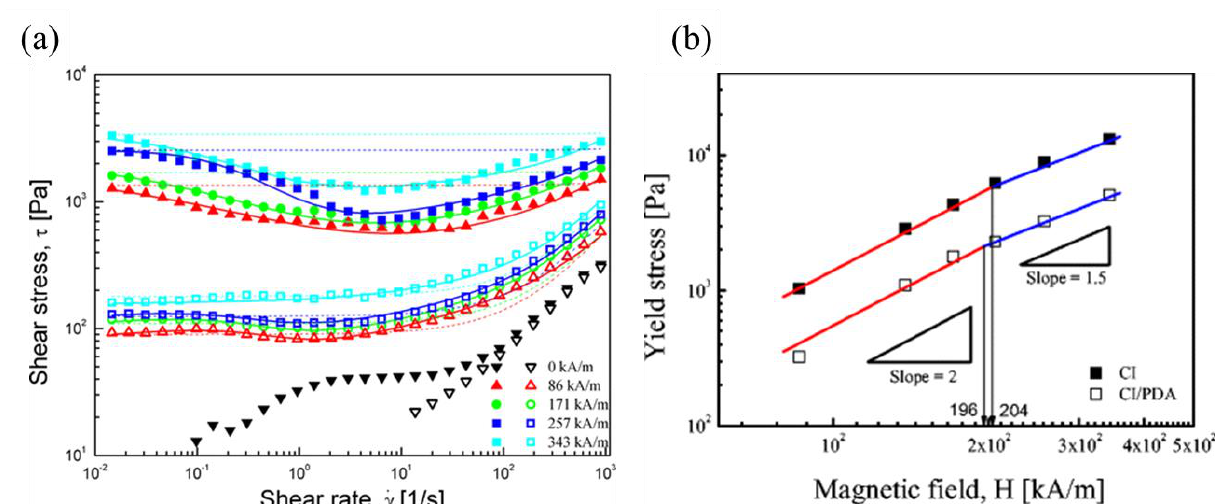
Figure 6. ( a ) Plots of shear stress vs. shear rate for pure Fe 2 O 3 (closed) and PS/Fe 2 O 3 (open) MR fluids at various magnetic field strengths (Kim et al. [74], ©American Chemical Society, 2013) with Bingham (dotted line) and Cho–Choi–Jhon (solid line) fits. ( b ) Magnetization curves of CI and CI/polydopamine powder as a function of the magnetic field strength (Kim et al. [65], ©Springer-Verlag Berlin Heidelberg,